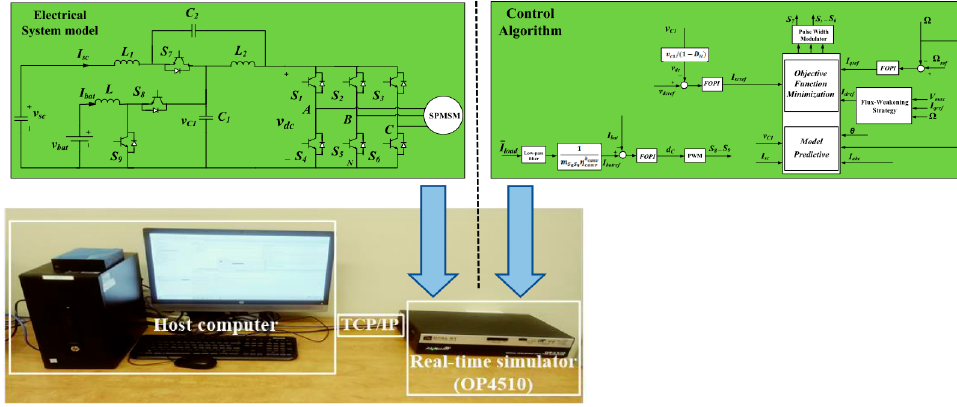
Figure 5. Real-time simulation setup. Table 2. Parameters of EV platform.